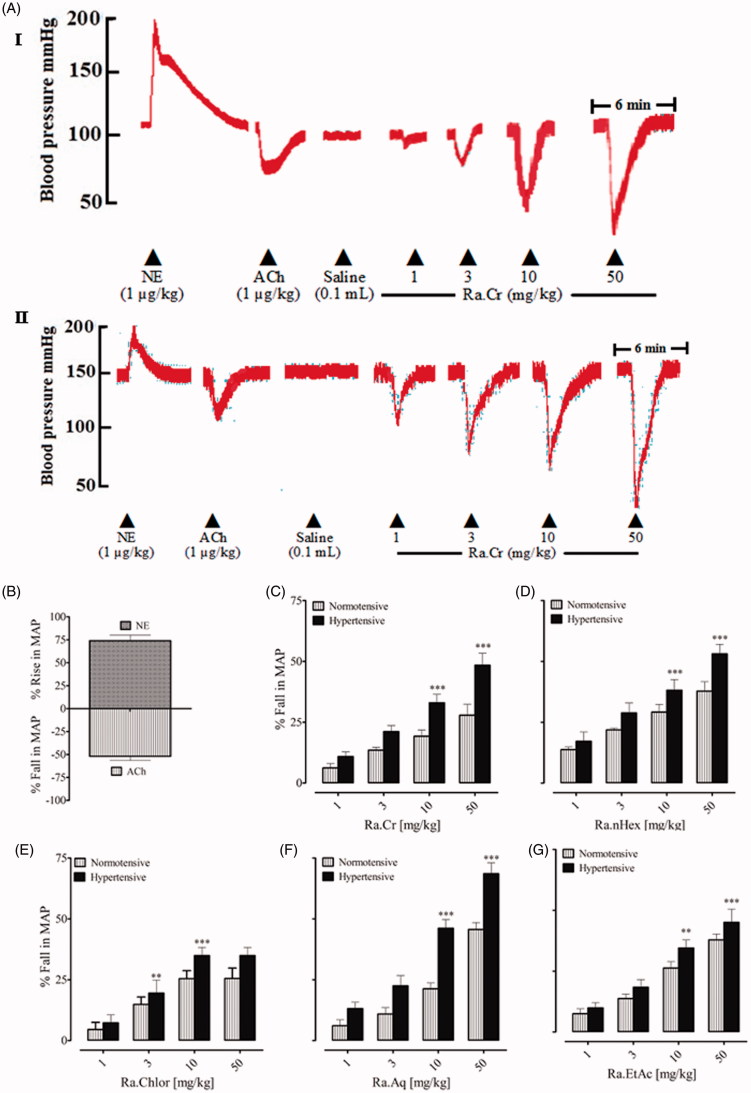
A representative tracing (A I) is showing the effect of norepinephrine (NE), acetylcholine (ACh) and the crude extract of Rumex acetosa (Ra.Cr) on blood pressure in normotensive and hypertensive rats (A II) under anaesthesia. (B) The hypertensive and hypotensive effects of NE and Ach, respectively. (C–G) The hypotensive response of the crude extract of Ra.Cr and its fractions in normotensive and hypertensive rats under anaesthesia. Values shown are mean ± SEM. Six determinations in either case. **p < 0.01, ***p < 0.001.